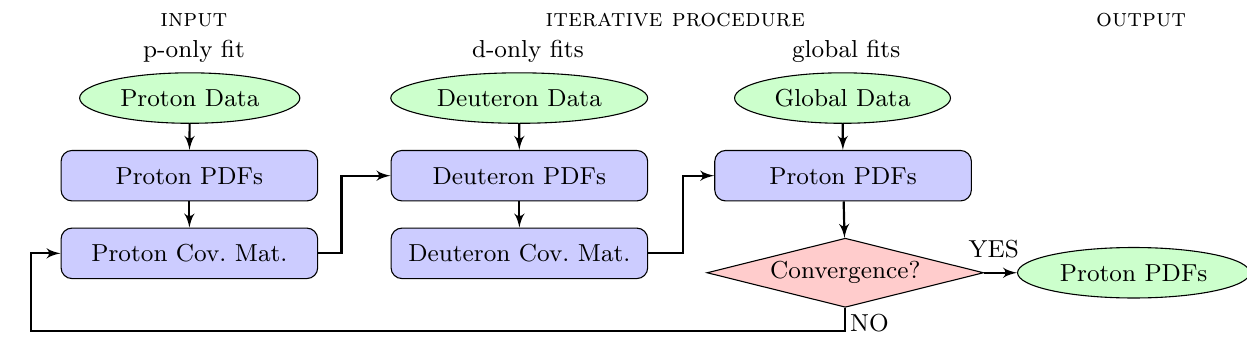
Fig. 1 A schematic representation of the iterative procedure adopted to determine the uncertainty due to deuteron corrections in proton PDF fits, see text for details. The global dataset is the union of the proton and deuteron datasets